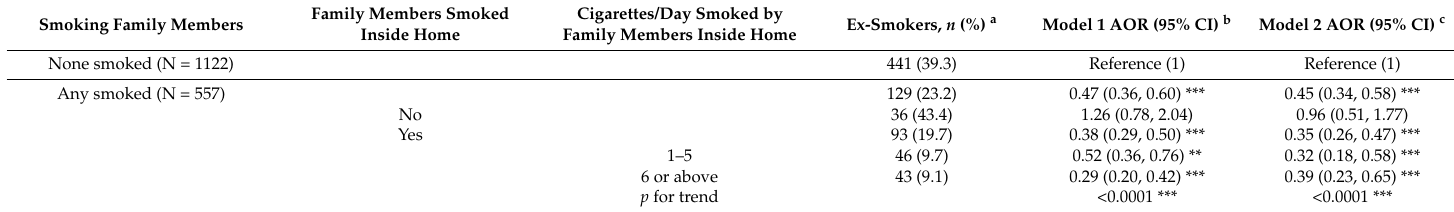
Table 2. Associations of second-hand smoke exposure at home and between ex-smoking in 1679 ever smokers at baseline.